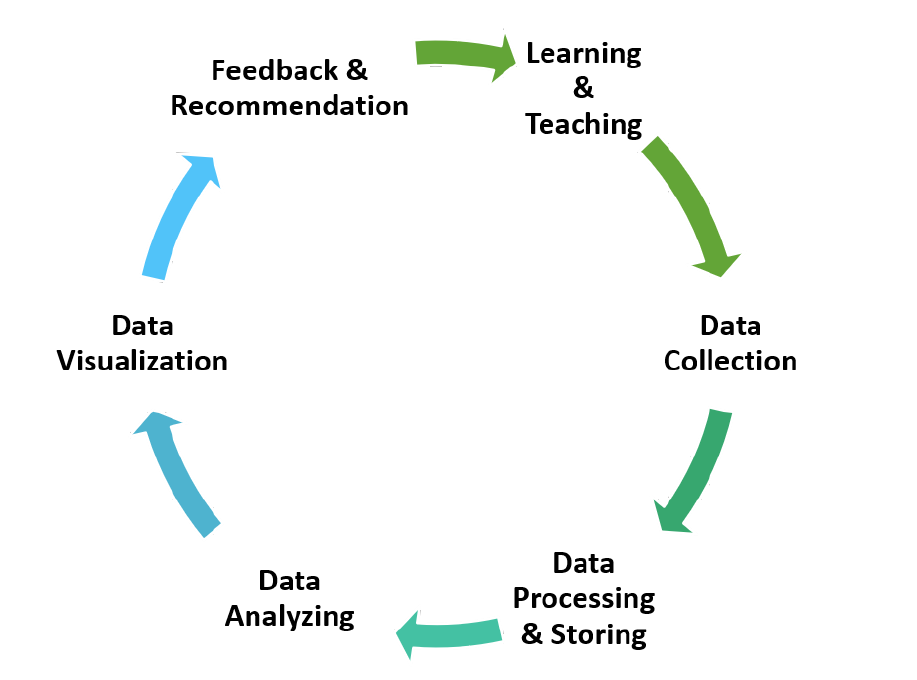
Figure 1. LA cycle following the guidelines of ISO/IEC TR